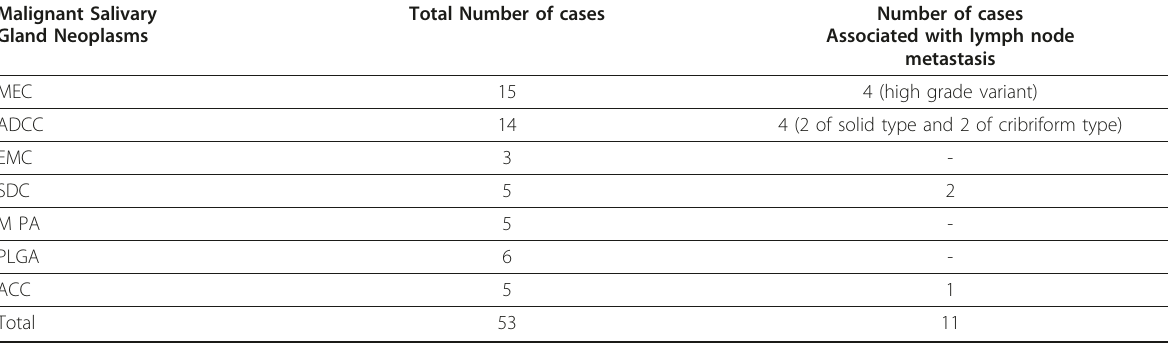
Table 1 Types of cases and association with lymph node metastasis of the selected cases Malignant Salivary Gland